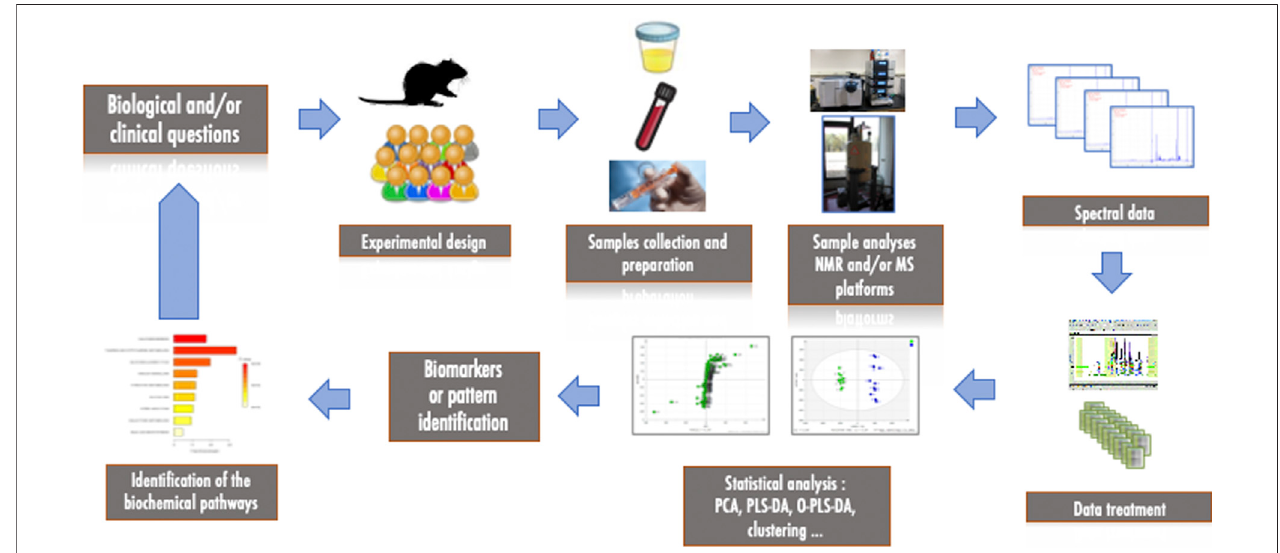
FIGURE 2 | Work fl ow of a metabolomics